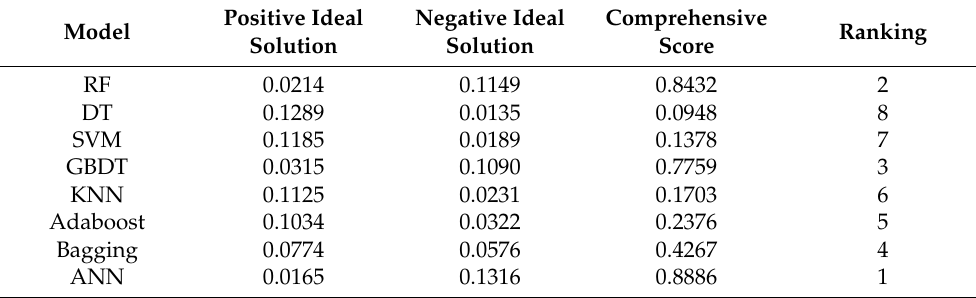
Table 4. Ranking results based on entropy weight-TOPSIS